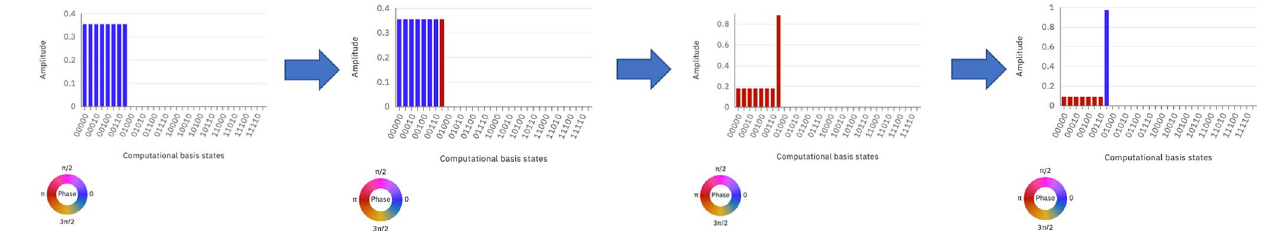
Figure 9. The effect of Grover’s algorithm on the the amplitude of each qubit state. The amplitudes of all 8 possible states of the three-qubit quantum chip are shown at various stages of the algorithm. The system is placed in an equal superposition (far left), with each state’s amplitude being 1 phase transformation and amplitude amplification of the target state are shown. The process is repeated in a second iteration, resulting in a greater target state amplitude (far